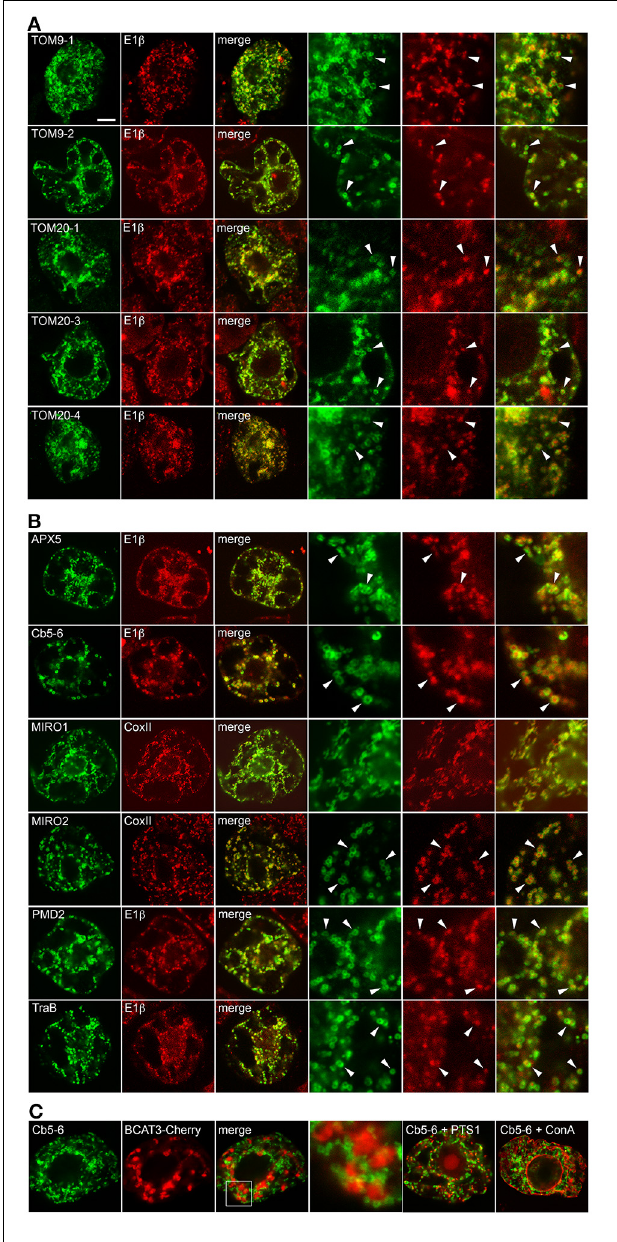
FIGURE 1 | Subcellular localization of selected A. thaliana OMM-TA proteins in BY-2 cells. BY-2 cells were transiently transformed with plasmid DNA expressing selected Myc-tagged TOM-TA proteins (A) or dibasic-motif-containing TA proteins (B) and immunostained for endogenous mitochondrial E1 β or CoxII, as indicated in the panel labels. Alternatively, in (C) , cells were (co-)transformed with Myc-tagged Cb5-6 and the plastid marker protein BCAT3-Cherry or the peroxisome marker protein (PTS1), which also includes the Cherry protein, or incubated with fluor-conjugated concanavalin A (ConA), serving as an ER marker stain (Tartakoff and Vassalli, 1983). Processing of cells for immunofluorescence microscopy and viewing using CLSM are as described in the “Materials and Methods.” Shown in the three panels on the right side of each row in (A) and (B) are images corresponding to a portion of the cell at higher magnification. Solid arrowheads indicate examples of the torus-shaped fluorescent structures containing the Myc-tagged TA protein delineating the